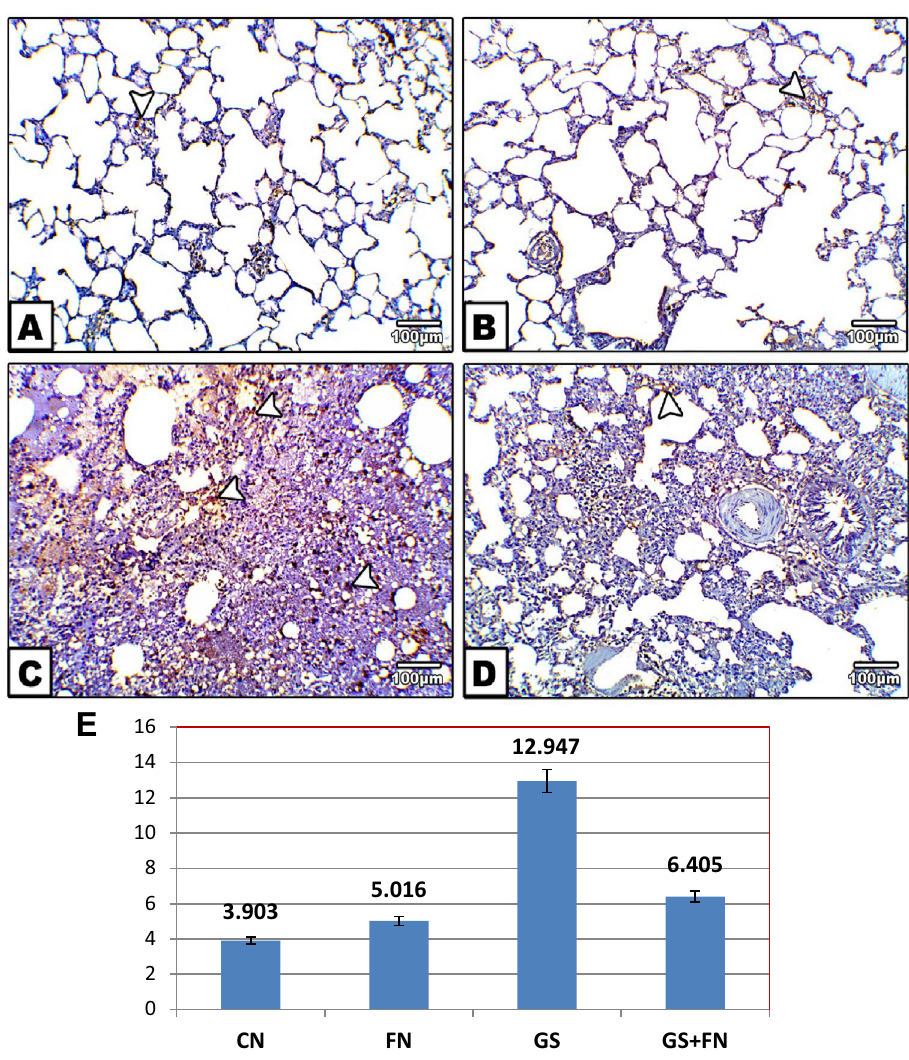
Figure 4. Photomicrographs of histological sections of lung immunohistochemically labeled by Bax primary antibody. Unexposed control and fenugreek groups ( A , B ) showing very little immunohistochemical reaction of Bax. The gasoline-exposed group ( C ) showed an increase in the dark brown color of the immunohistochemical reaction of Bax in inflamed lung cells. Gasoline-exposed group-administered fenugreek seeds ( D ) showed a decrease in the immunohistochemical reaction of Bax. Arrowhead pointed to the increase in the immunohistochemical reaction of Bax. ( E ) Histogram showing the percentage of immunohistochemical reaction of Bax in the lung of rat groups using image